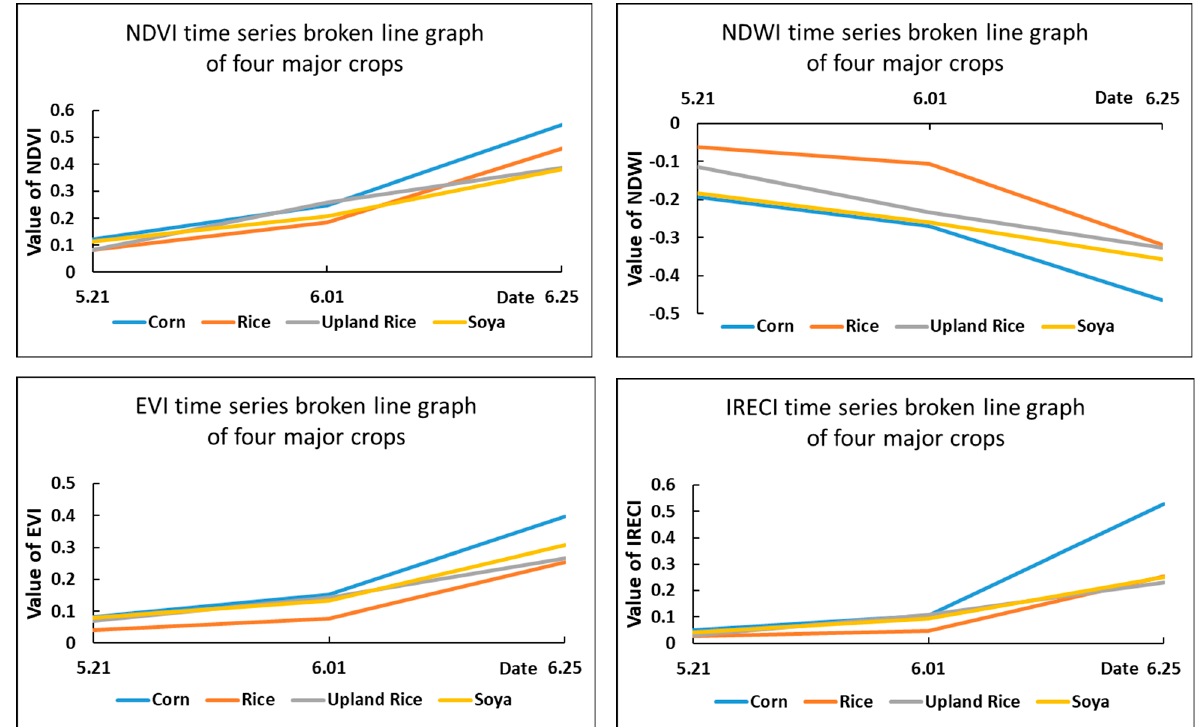
Figure 4. Time series broken line statistics of the spectral features.